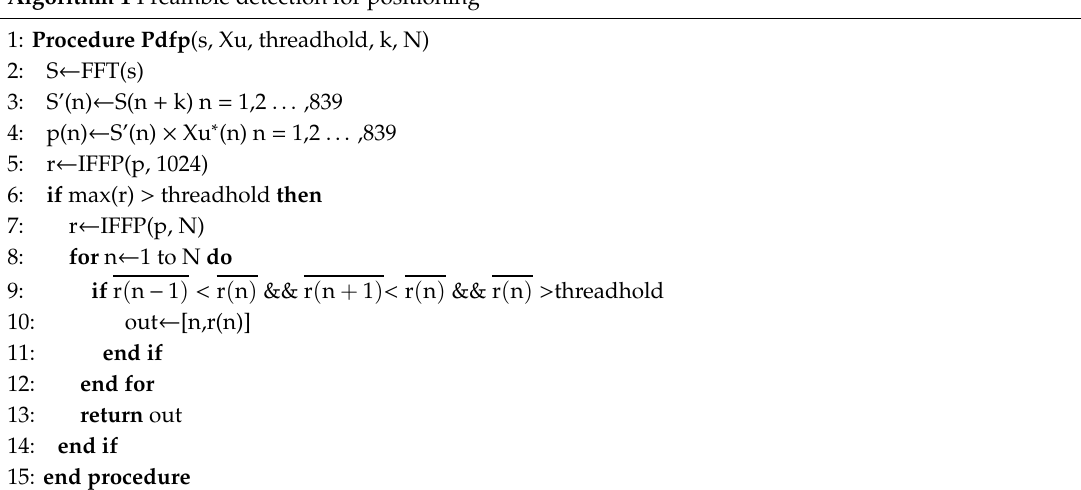
Algorithm 1 Preamble detection for